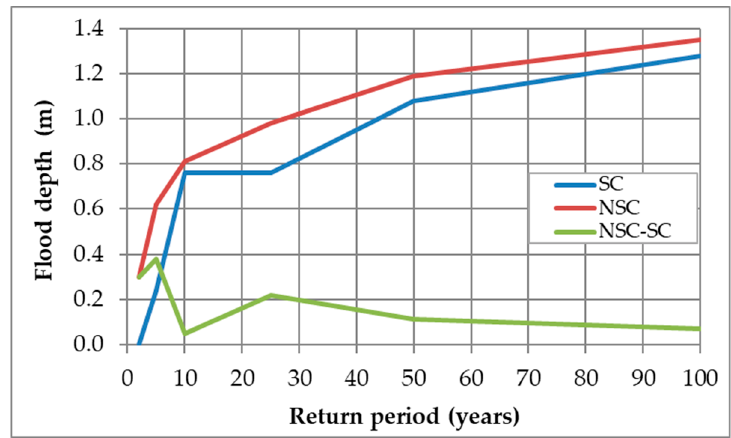
Figure 14. Flood depth at cross-section K0+018.5.